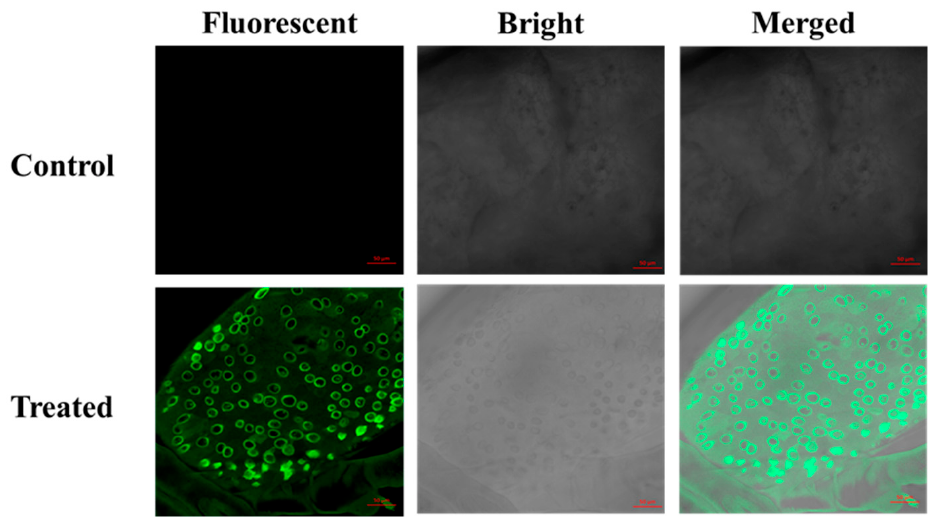
Figure 6. CLSM images of the midgut of P. xylostella treated with FL-SiO 2 NPs (Bar scales: 50